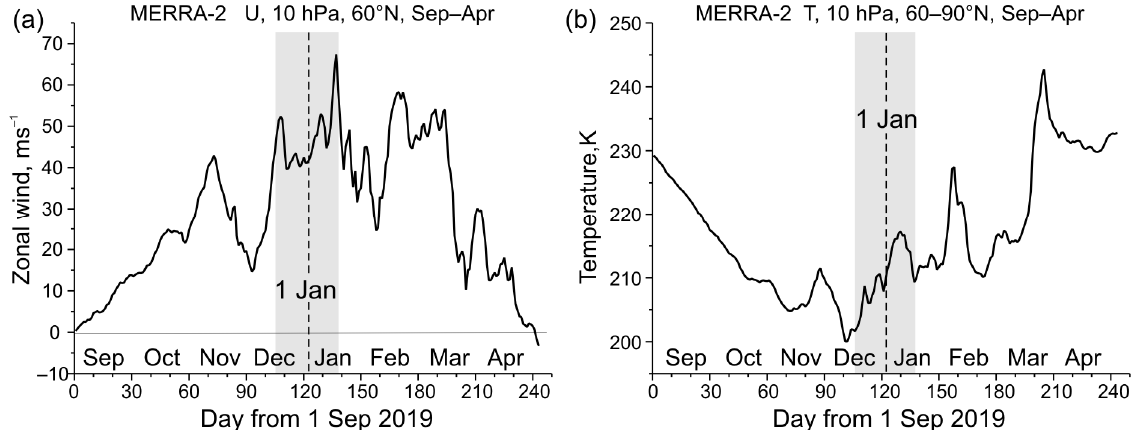
Figure 1. MERRA-2 [40] data for ( a ) zonal wind at 10 hPa, 60 ° N and ( b ) polar temperature at 10 hPa, 60–90 ° N, in September 2019–April 2020. The gray rectangles show the time interval from mid- December to mid-January, which stands out in the variability of the zonally asymmetric stratopause (Section 3.2).